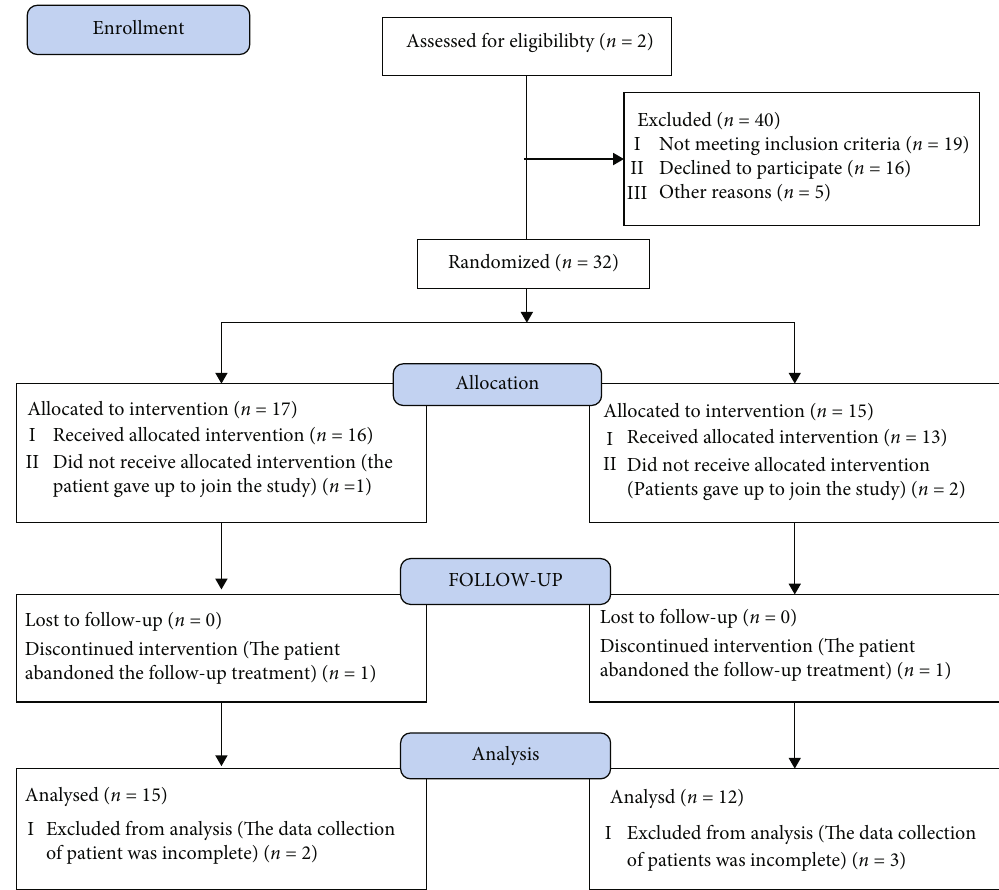
Figure 1: Procedure for participating in this study. A total of 32 patients were included in this study from March 1, 2016, to July 31, 2018, and 3 patients did not receive allocated intervention because of the absence of therapy, and 2 patients discontinued intervention for their personal